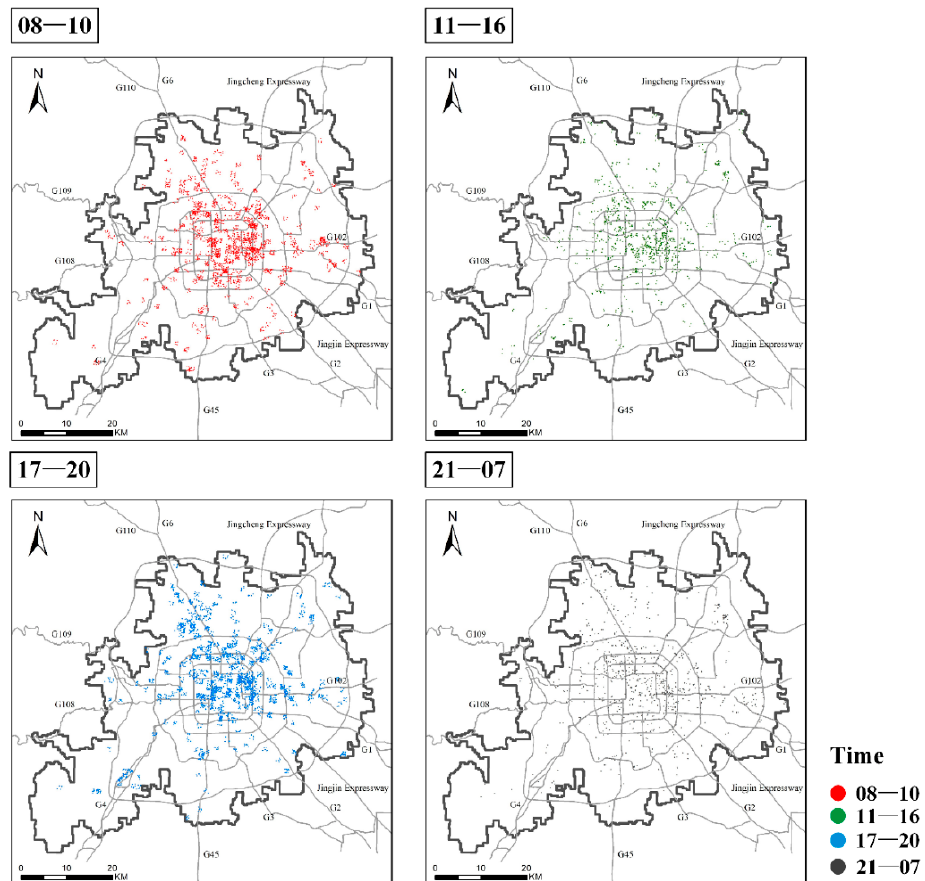
Figure 10. Dot maps of in different time periods based on grid cells.